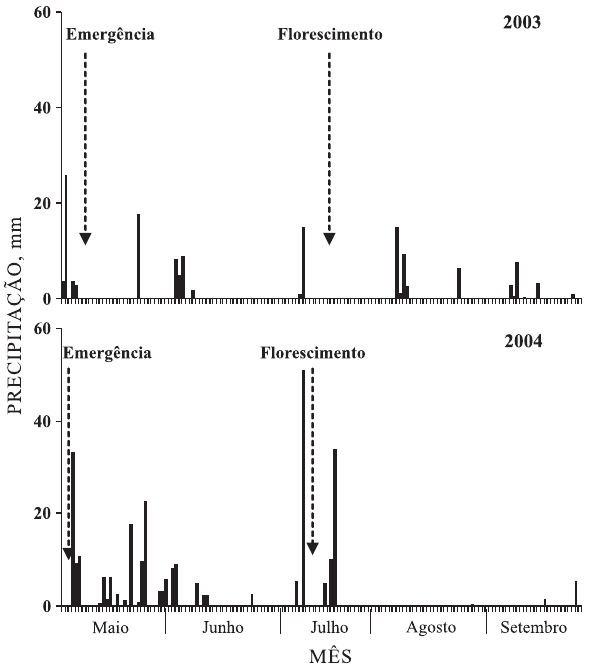
Figura 1. Valores diários de precipitação pluvial (mm dia -1 ) obtidos na área experimental, durante o período de maio a setembro, nos anos de 2003 e 2004, e datas de emergência e florescimento pleno da cultura da aveia-preta. Botucatu,